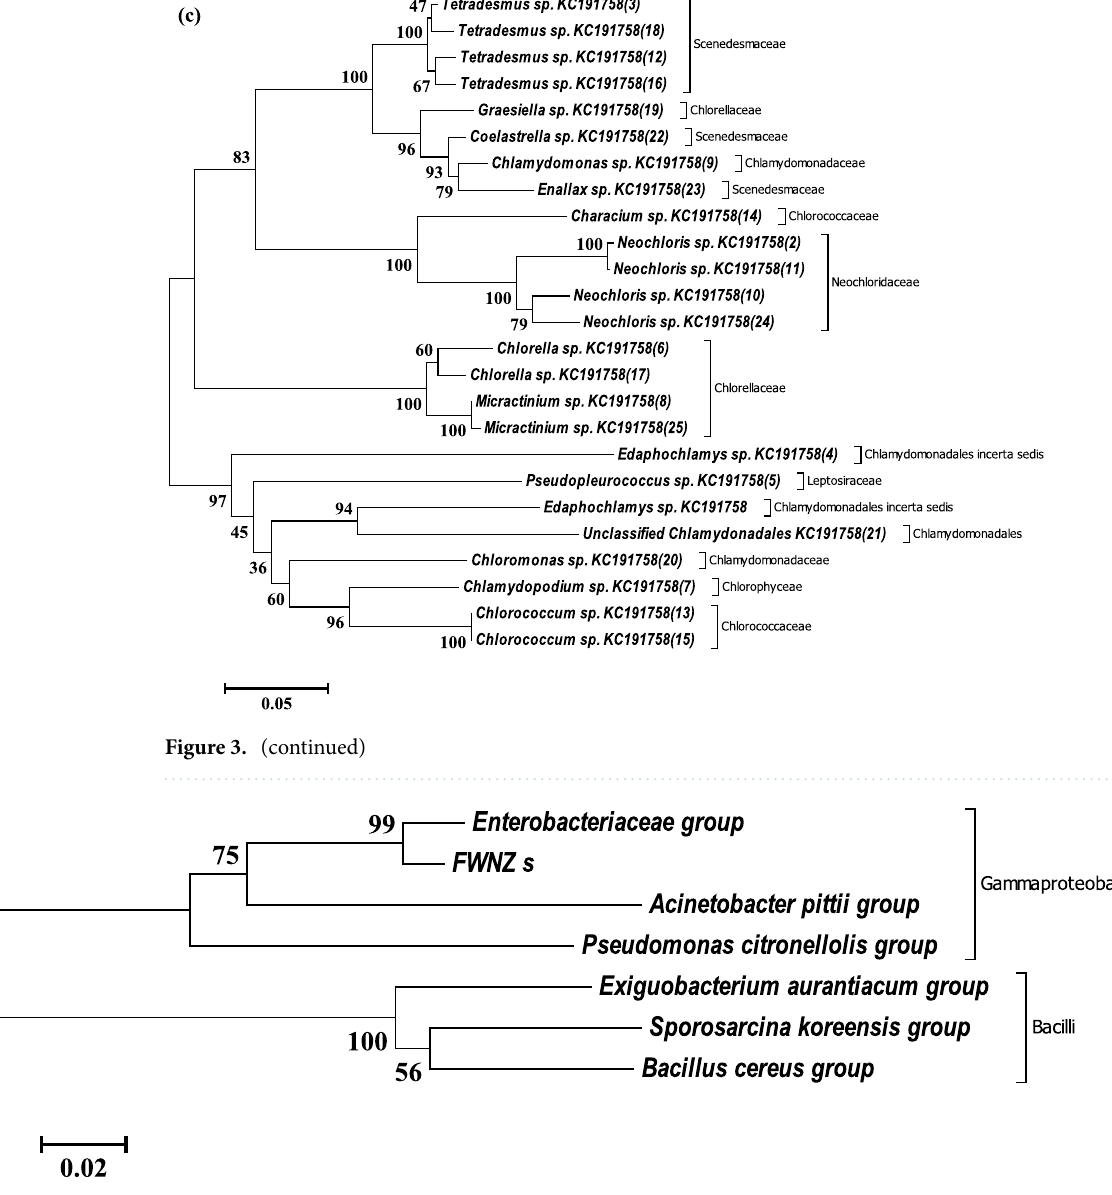
Figure 4. Evolutionary relationships of bacteria taxa that form consortium used in HMs sequestration of AMD from ‘Onyeama’ coal mine. The evolutionary history was inferred using the Neighbor-Joining method upon alignment via MUSCLE. The tree was drawn to scale, with branch lengths in the same units as those of the evolutionary distances used to infer the unrooted phylogenetic tree. The evolutionary distances were computed using the Maximum Composite Likelihood method with pairwise deletion and 1000 bootstrap replicates (bootstrap value > 50%). Evolutionary analyses were conducted in